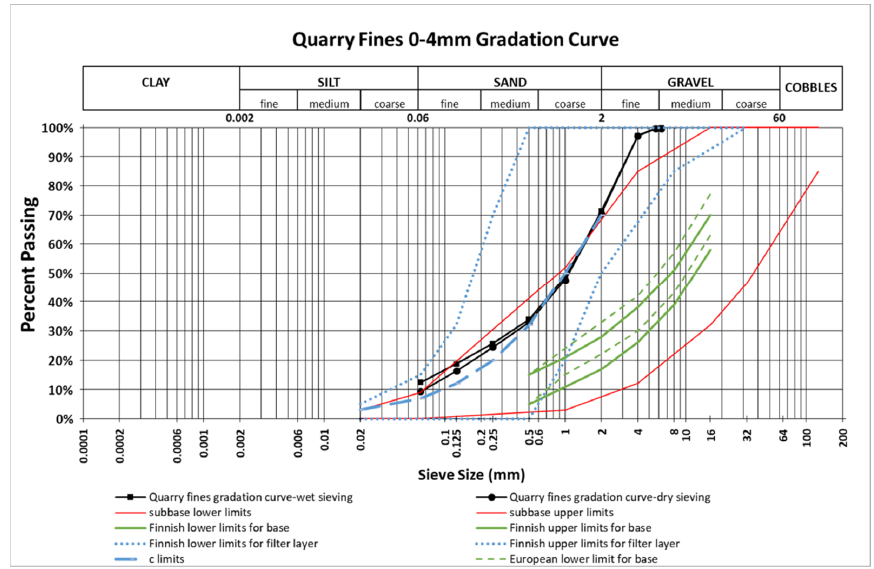
Figure 1. Gradation curves of quarry fines with a 0–4 mm particle size and the limits for pavement base, subbase, and filter layers according to Finnish and European requirements.